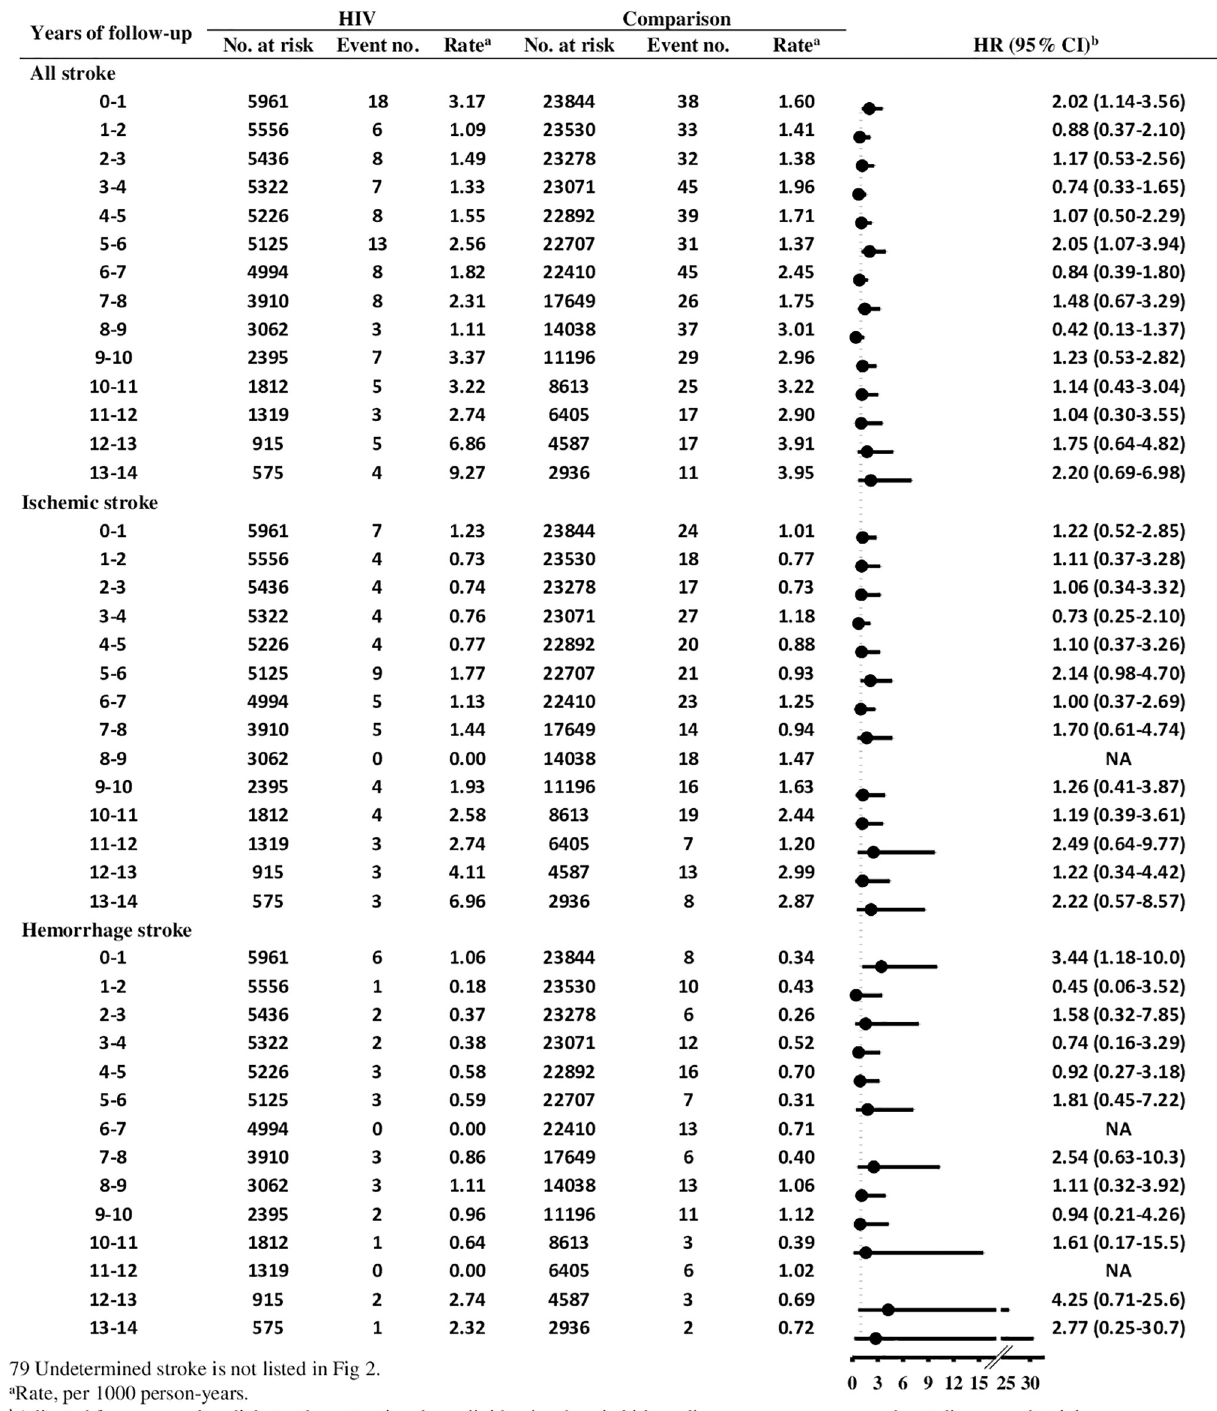
Fig 2. Risk of stroke in association with HIV infection according to time of follow-up.